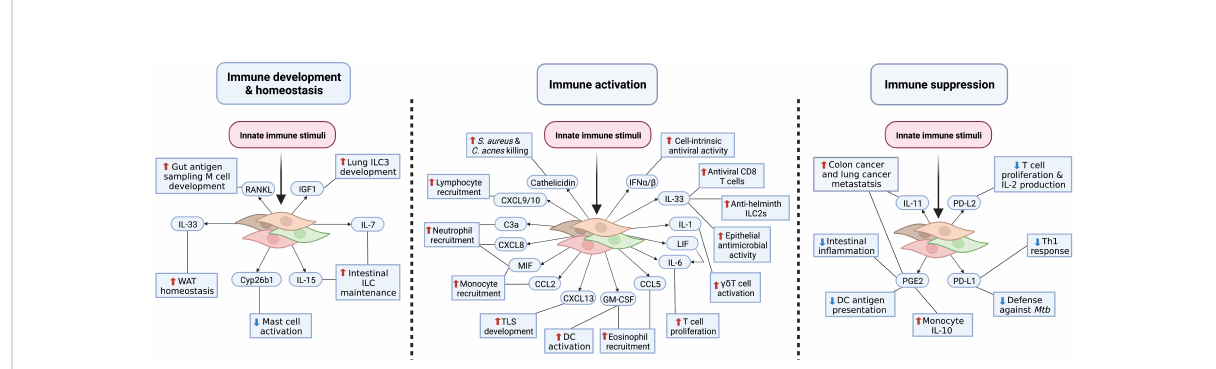
FIGURE 3 Fibroblast innate immune effector functions. Barrier tissue immune acting fi broblasts elicit innate immune functions required for development and homeostasis, immune activation, and immunosuppression. During steady-state conditions, fi broblasts produce cytokines and growth factors necessary for immunological priming and homeostasis (left panel). To potentially eliminate pathogens, fi broblasts release antimicrobial peptides, chemokines, and proin fl ammatory cytokines (middle panel). Left unchecked, this defense response could contribute to chronic in fl ammatory conditions. To limit excessive and protracted immune responses and prevent in fl ammatory disease pathogenesis, fi broblasts upregulate immune checkpoint molecules, suppressive bioactive lipid mediators, and anti-in fl ammatory cytokines; however, inappropriate fi broblast immunosuppression may increase risk of infection and cancer (right panel). This fi gure represents an amalgamation of proposed barrier tissue fi broblast innate immune effector functions. It is unclear whether each fi broblast subtype/state across tissues is capable of achieving an activation state that will enable these